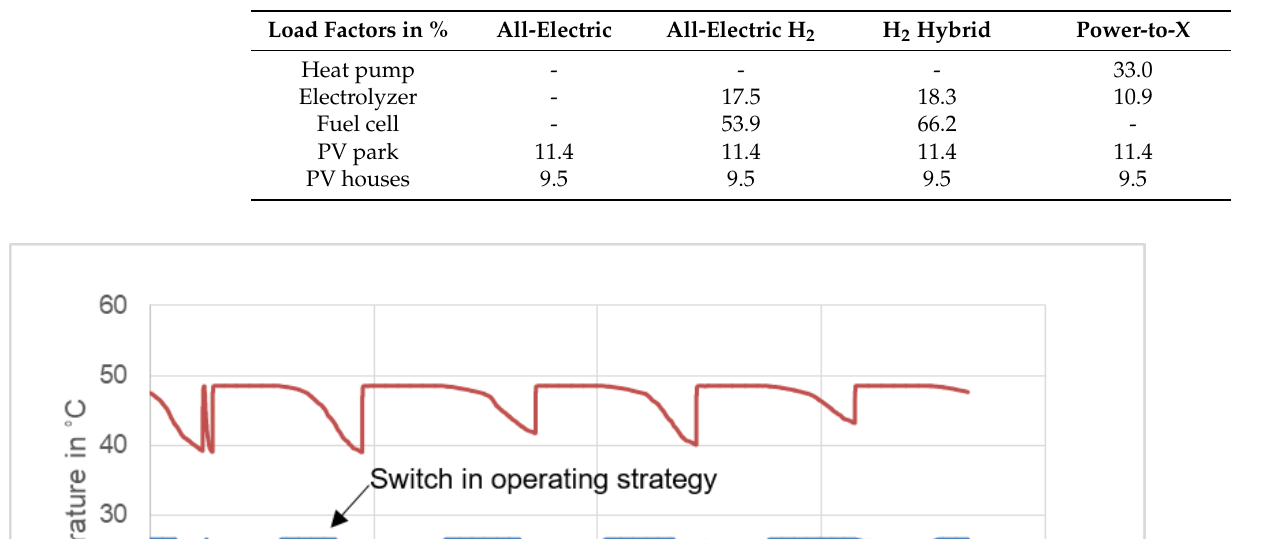
Table 6. Load factors of main system components for all scenarios, based on a five-year average.